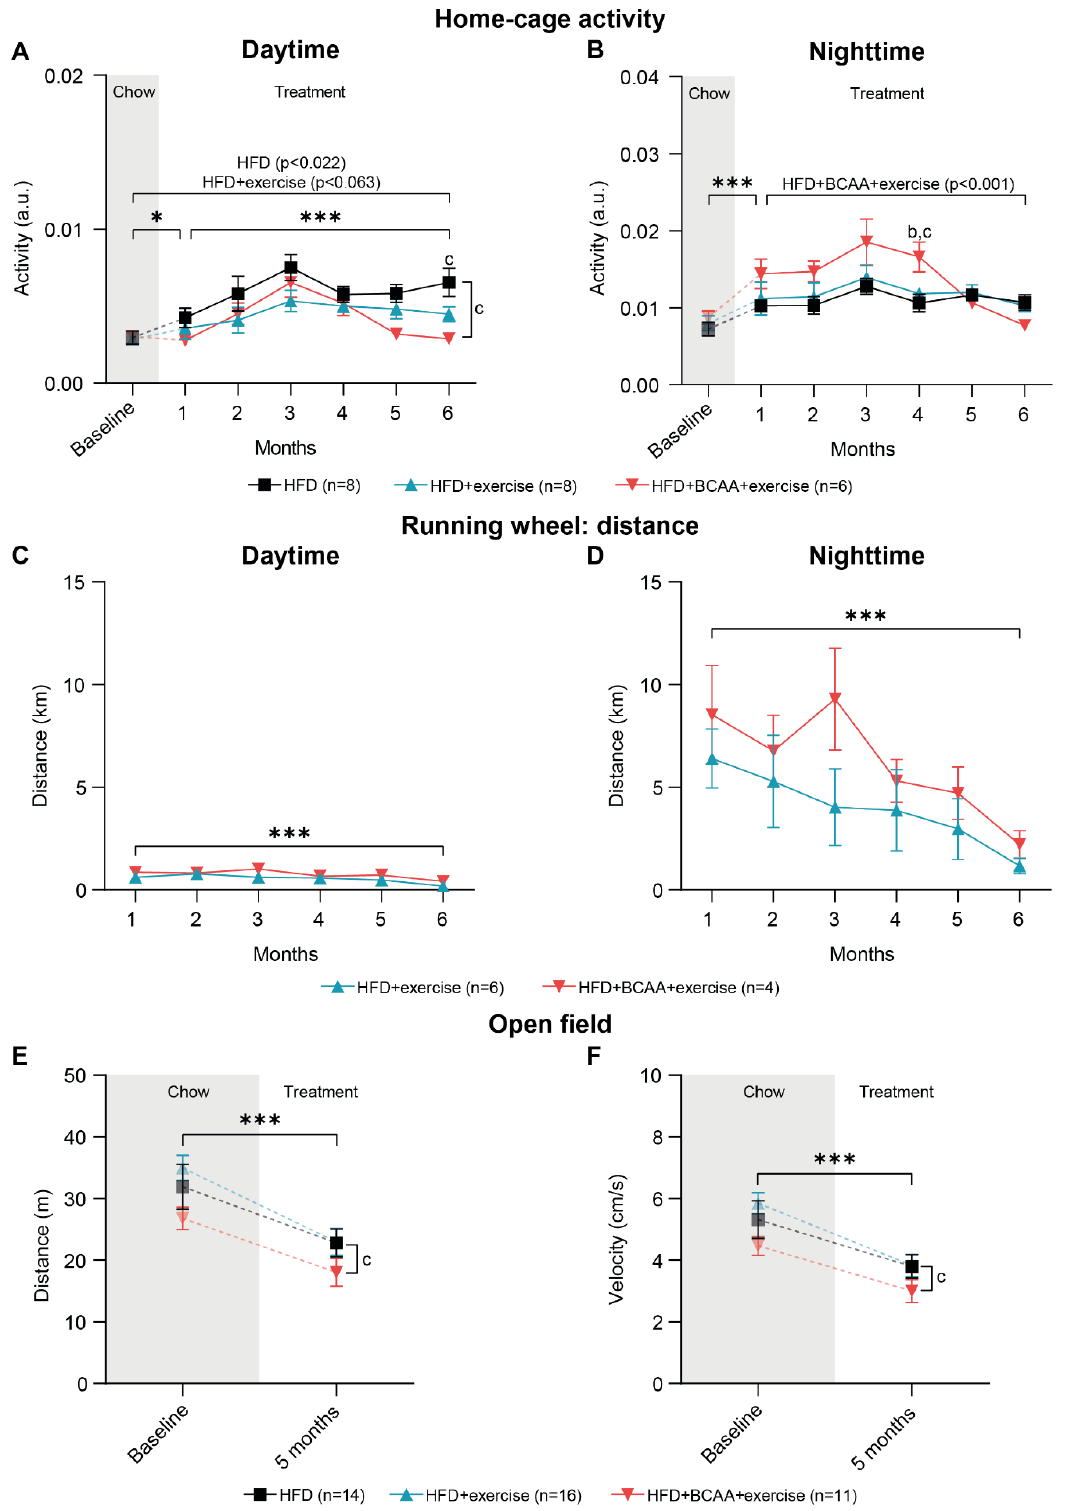
Figure 4. Home-cage activity, voluntary exercise, and open field test. Digital ventilated cages recorded home-cage activity and voluntary exercise of HFD, HFD + exercise, and HFD + BCAA + exercise mice 24/7 at baseline (chow) and during the consecutive 6 treatment months. In detail, average home-cage activity during ( A ) daytime and ( B ) nighttime as well as total running distance on the running wheel during ( C ) daytime and ( D ) nighttime were assessed. Moreover, the effect of exercise and exercise in combination with BCAA supplementation on ( E ) distance and ( F ) velocity during a 10-minute exploration period were analyzed in an open field test at baseline and after 5 months of